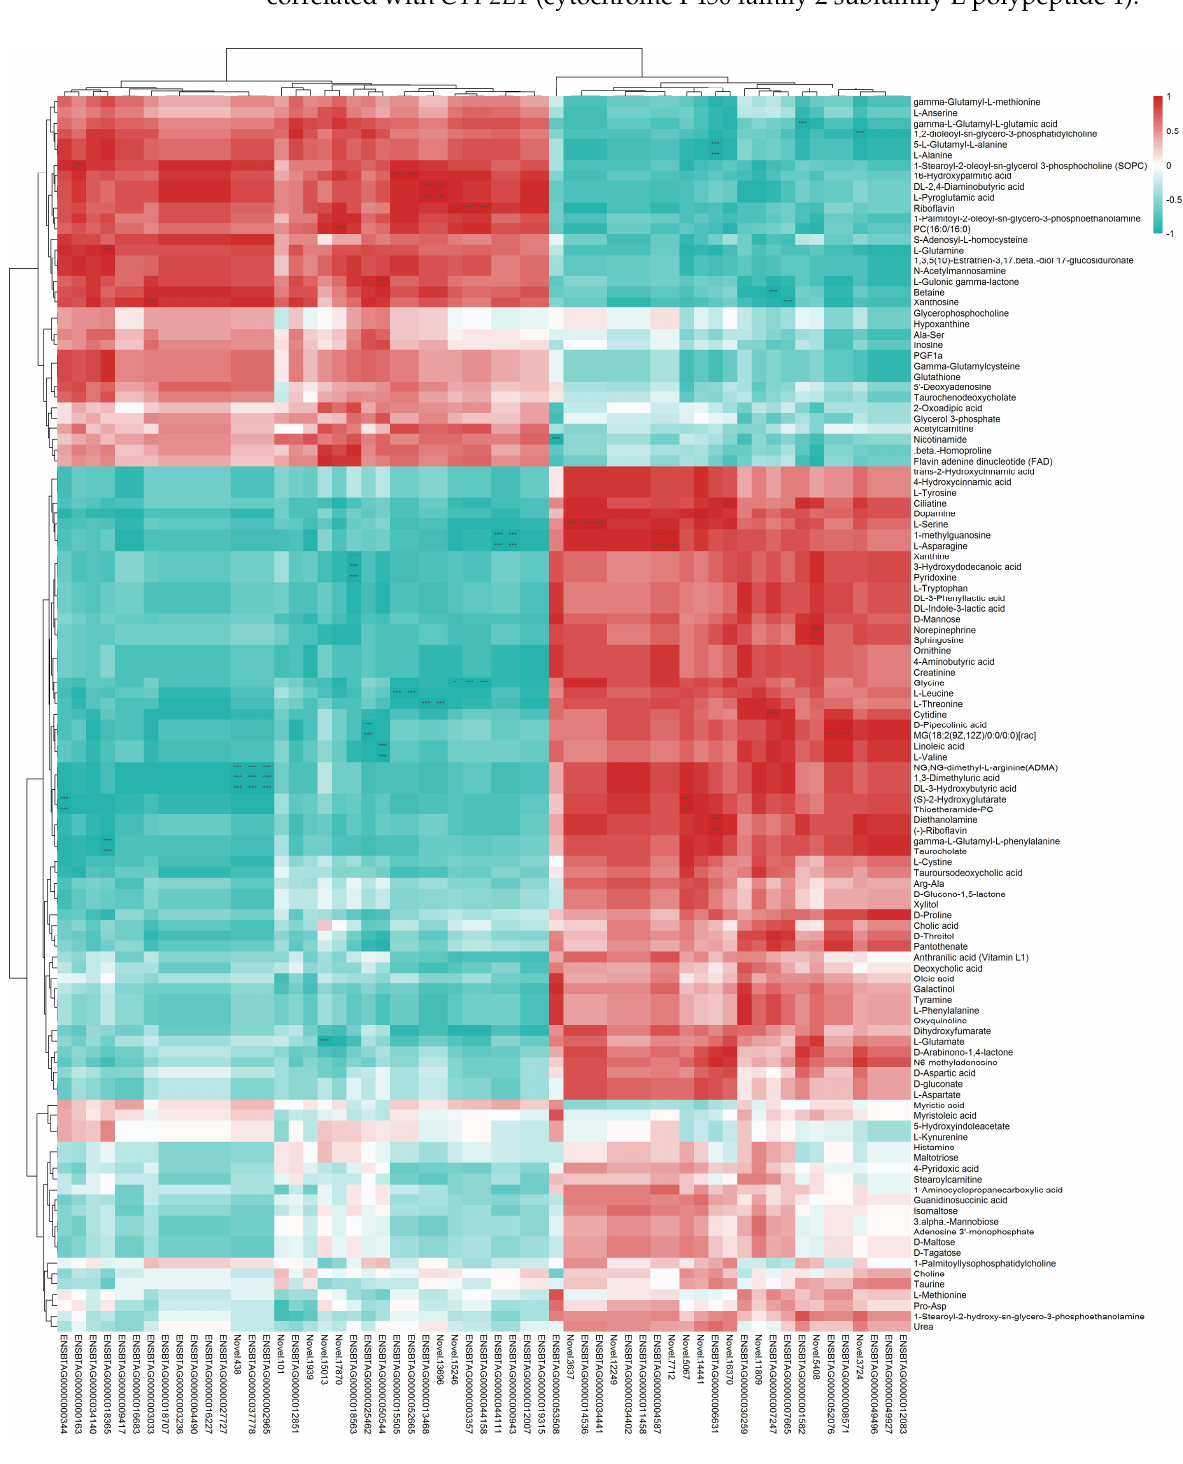
Figure 6. Pearson’s correlations between differentially expressed genes and differential metabolites in the comparison between GL16 and YL16. * p < 0.05; *** p < 0.001. GL16 = non−castrated and slaughtered at 16 months of age; YL16 = castrated at birth and slaughtered at 16 months of age.